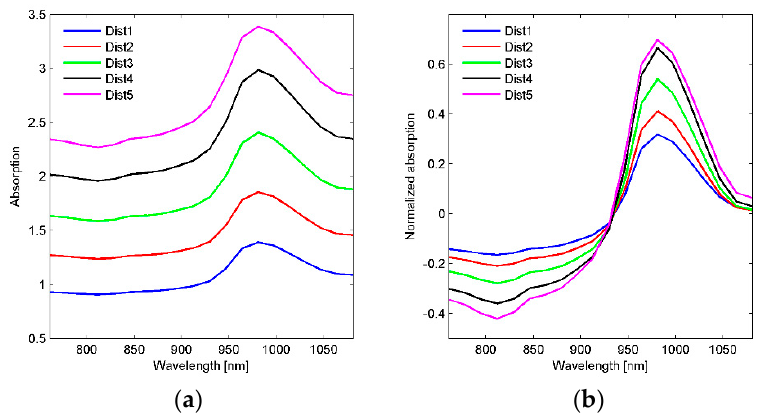
Figure 2. ( a ) Absorption spectra for the five different distances from one Innovator potato, indicated with Dist1 to Dist5. ( b ) Same measurements as in 2 ( a ), but with mean value subtracted from each spectrum.